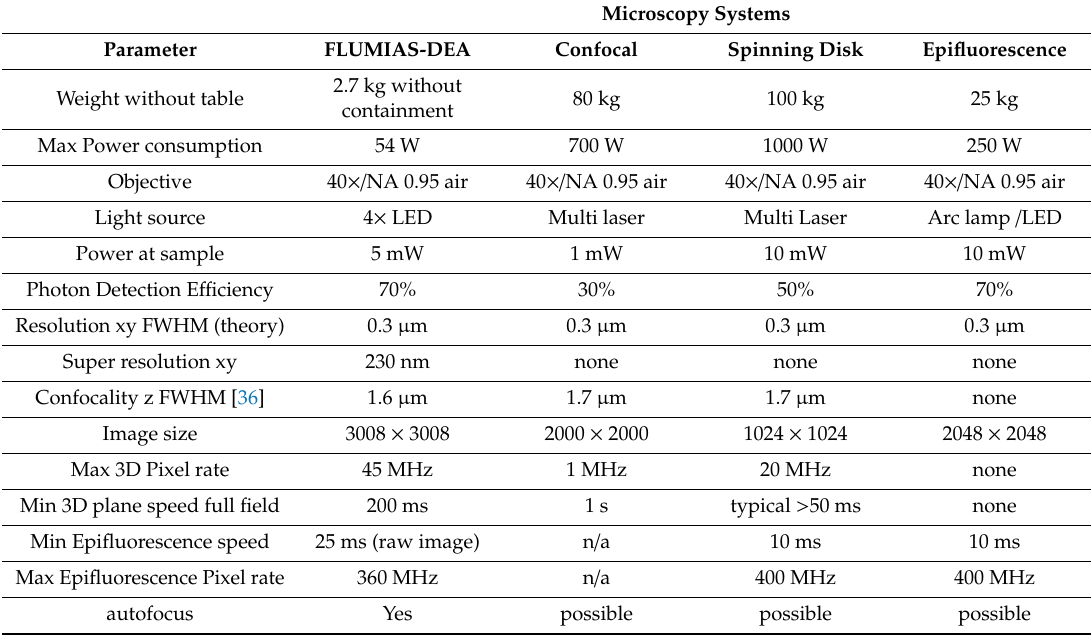
Table 5. Comparison of features and characteristics of structured illumination microscopy (SIM)